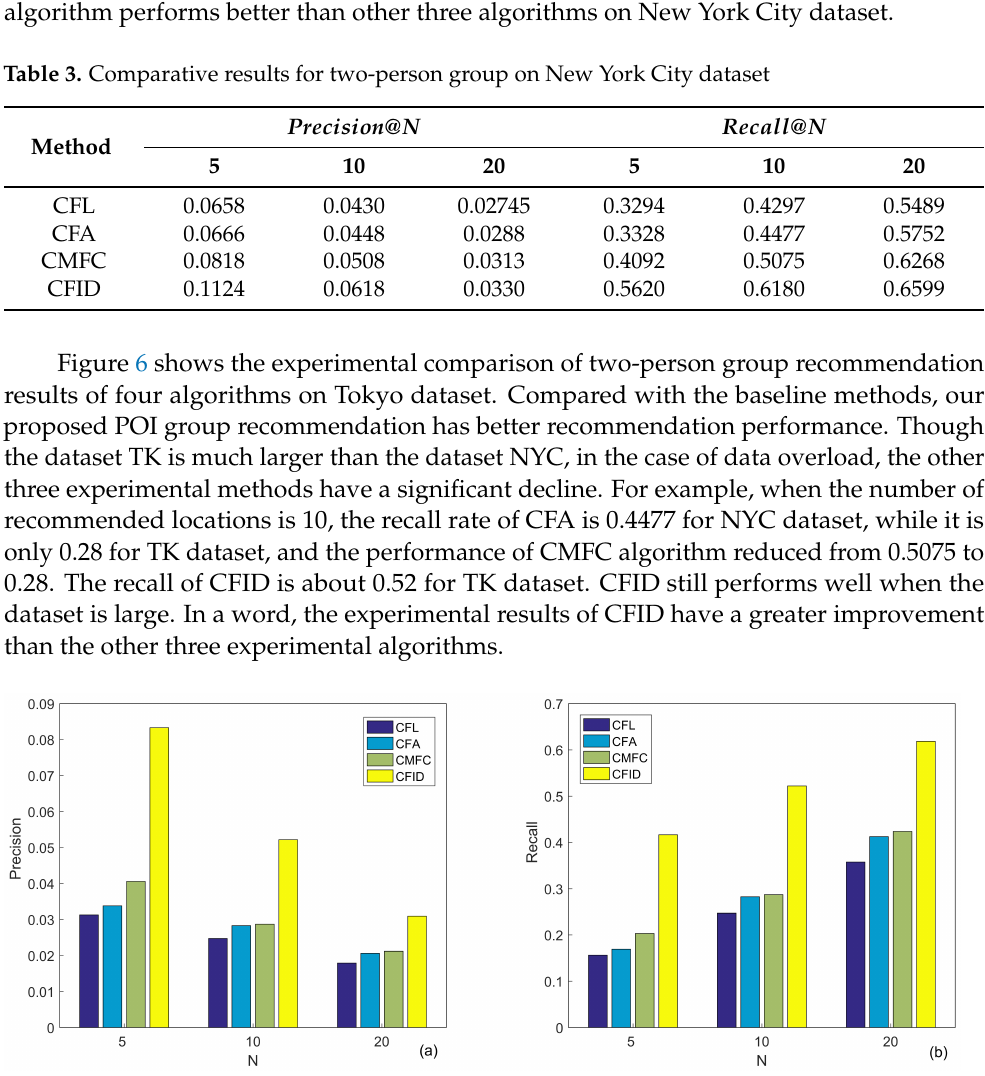
Figure 6. Two-persongroup recommendation results of four algorithms on Tokyo dataset. ( a ) preci- sion result; ( b ) recall